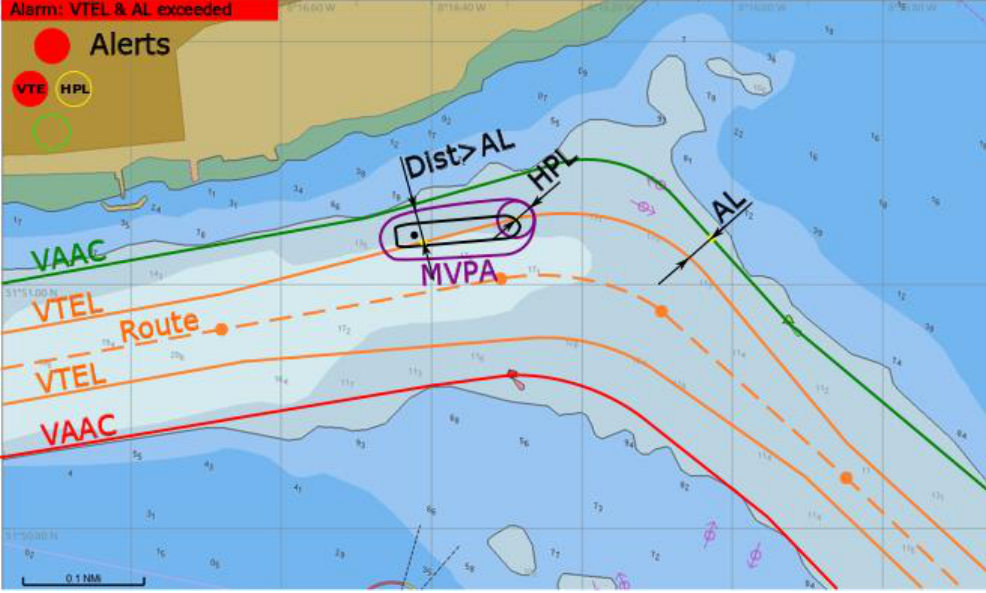
Figure 13. Alarm of high VTE raised, conceptual presentation in ECDIS.